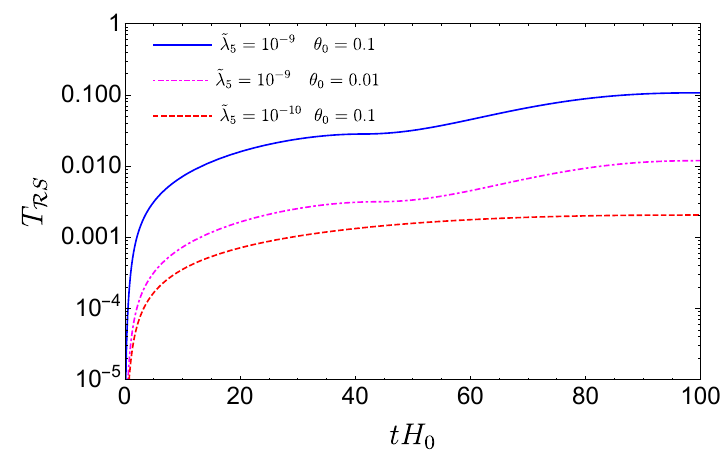
Figure 5 . The evolution of T R S during inflation for different parameter values for λ 5 and θ 0 . The other input parameters are fixed to ξ = 300 and λ = 4 . 5 · 10 − 5 , with initial conditions χ ˙ χ = 0 , and ˙ θ = 0 chosen. We choose ˜ µ to be sufficiently small to not affect the 0 0